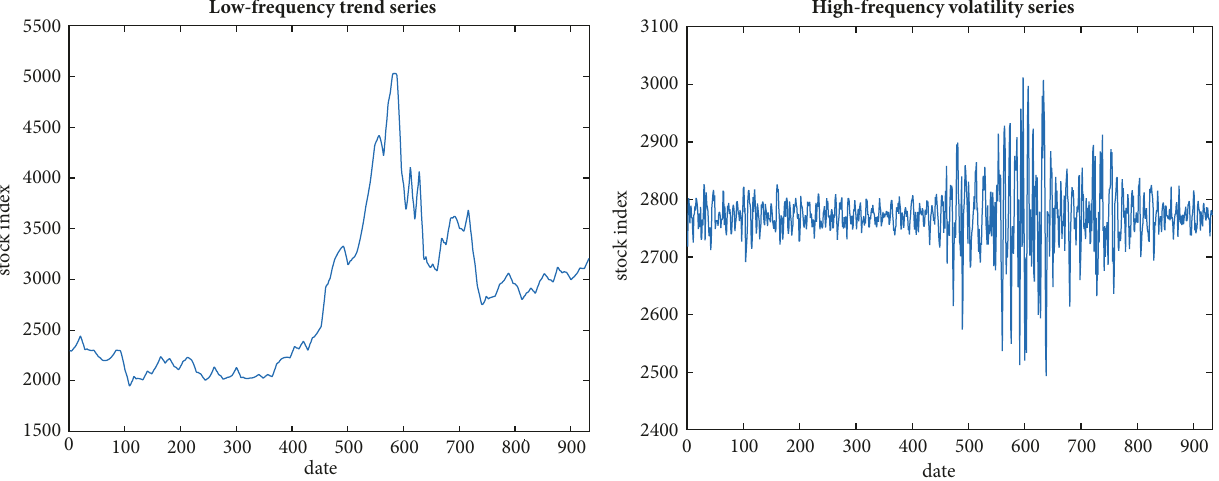
Figure 2: LF trend series and HF volatility series.